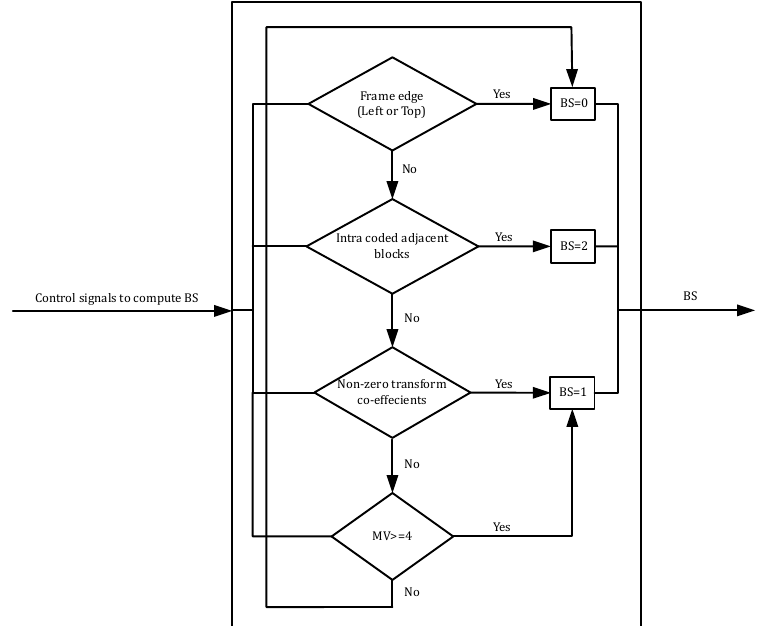
Figure 5. Boundary strength computation